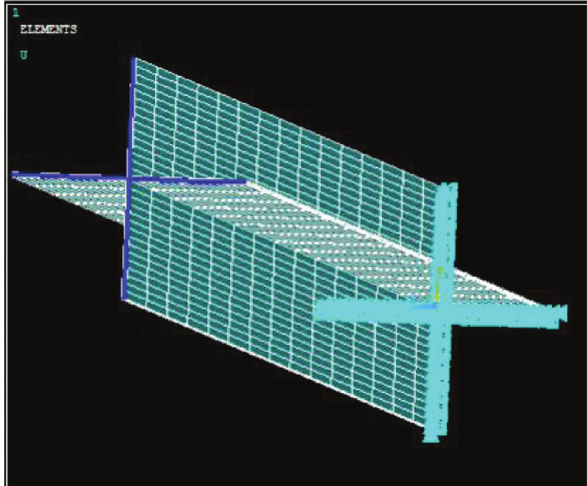
Figure 2 Finite element model for unstiffened cruciform-shaped